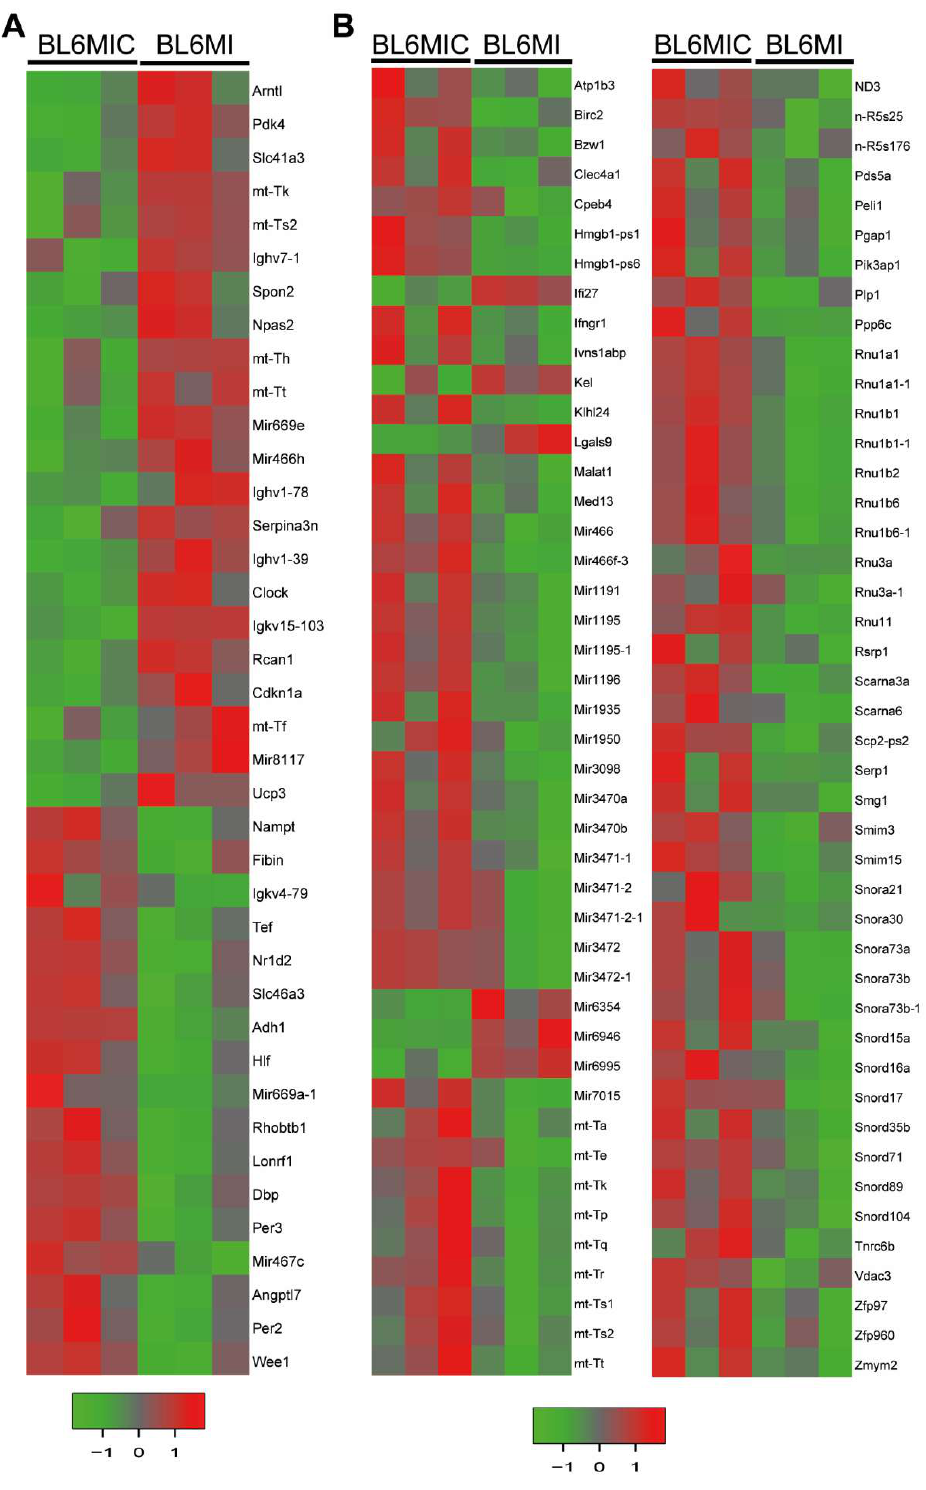
Figure 5. Cardiomyocyte transplantation has varied effects on the gene expression in the heart and blood. Heatmap of annotated differentially expressed (DE) transcripts found between BL6MIC and BL6MI in the heart ( A ) and blood ( B ). Transcripts are considered DE if they show a two-fold change and have a p -value < 0.05. Upregulated targets are colored red while the downregulated targets are colored green.